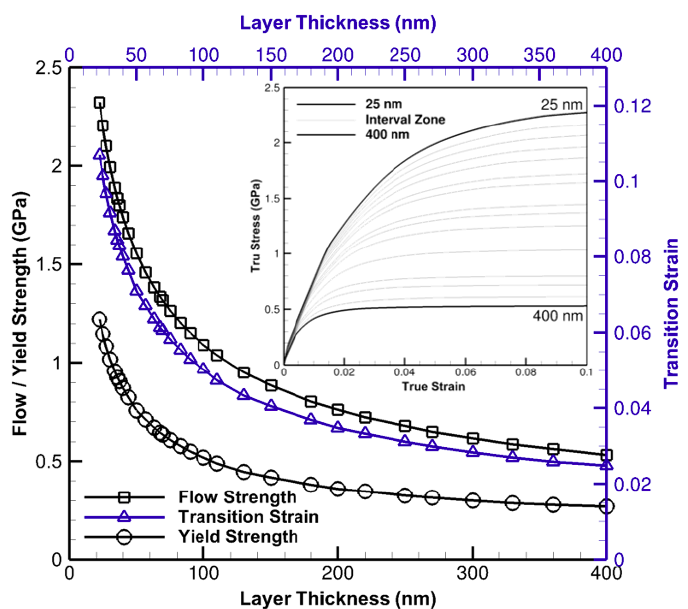
Figure 6. The variation of flow and yield strength ( left vertical axis ) as well as transition strain ( right vertical axis ), respectively, with respect to layer thickness in the range of 25 nm to 400 nm. The true stress-strain curves in this range is attached to the top right corner to clarify the overall constitutive